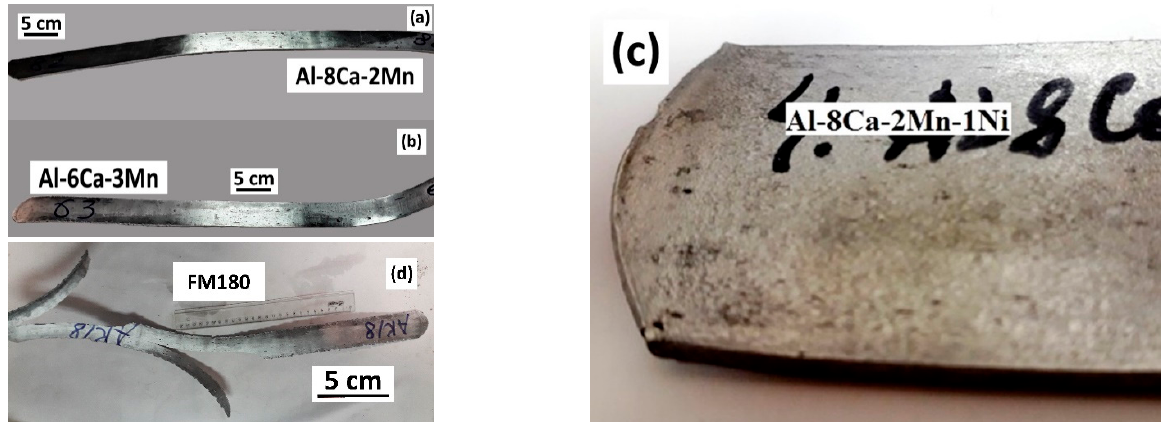
Figure 8. Hot-rolled sheets: ( a ) Al-6Ca-3Mn; ( b ) Al-8Ca-2Mn; ( c ) Al-8Ca-2Mn-1Ni; ( d ) FM180.